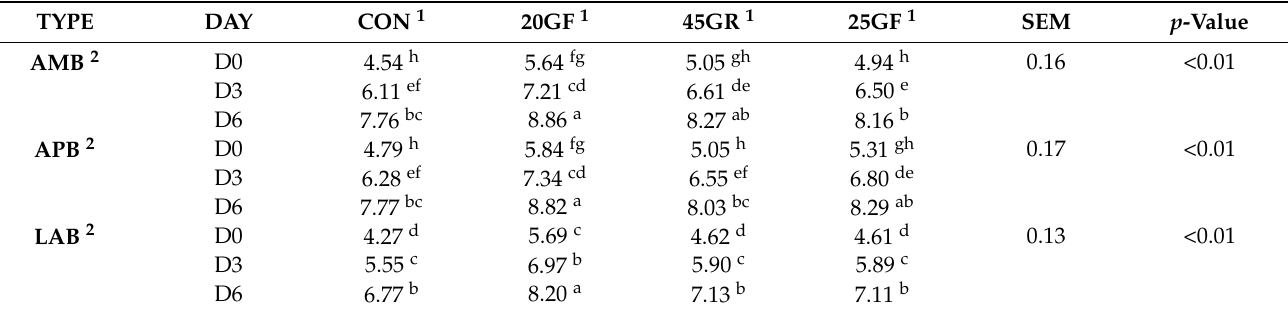
Table 1. Least square means of bacterial counts (log CFU/g) for beef steaks from different feeding systems 1 during six days of retail display at 4 ◦ C.